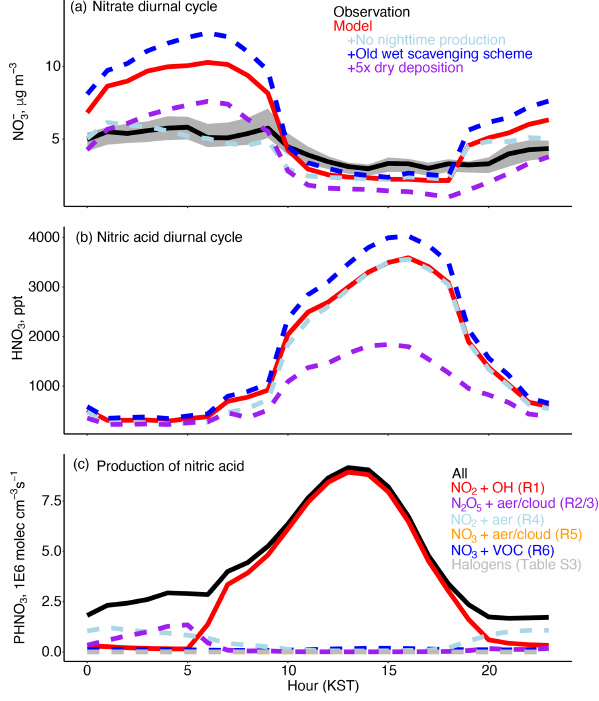
Figure 4. (a) Mean hourly modeled vs. observed nitrate de- rived from PM 2 . 5 observations in the GEOS-Chem grid box and KIST speciated composition as described in Sect. 4 for 1 May to 7 June 2016. The gray shading indicates the observed 25th to 75th percentile across the grid box. The model sensitivity studies are described in Sect. 5. (b) Mean model nitric acid diurnal cy- cle. (c) Mean model reactions that produce HNO 3 as described in Sect. 3.